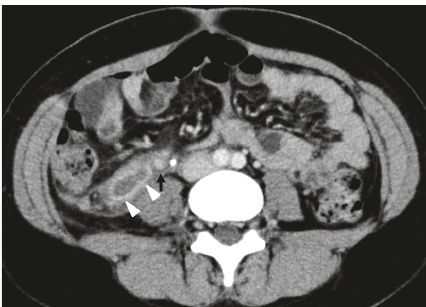
Figure 1: Abdominal dynamic CT scan (delayed phase). A ring- enhanced right retroperitoneal mass (white arrowhead). It was distinct from the right ovarian vein (black arrow).